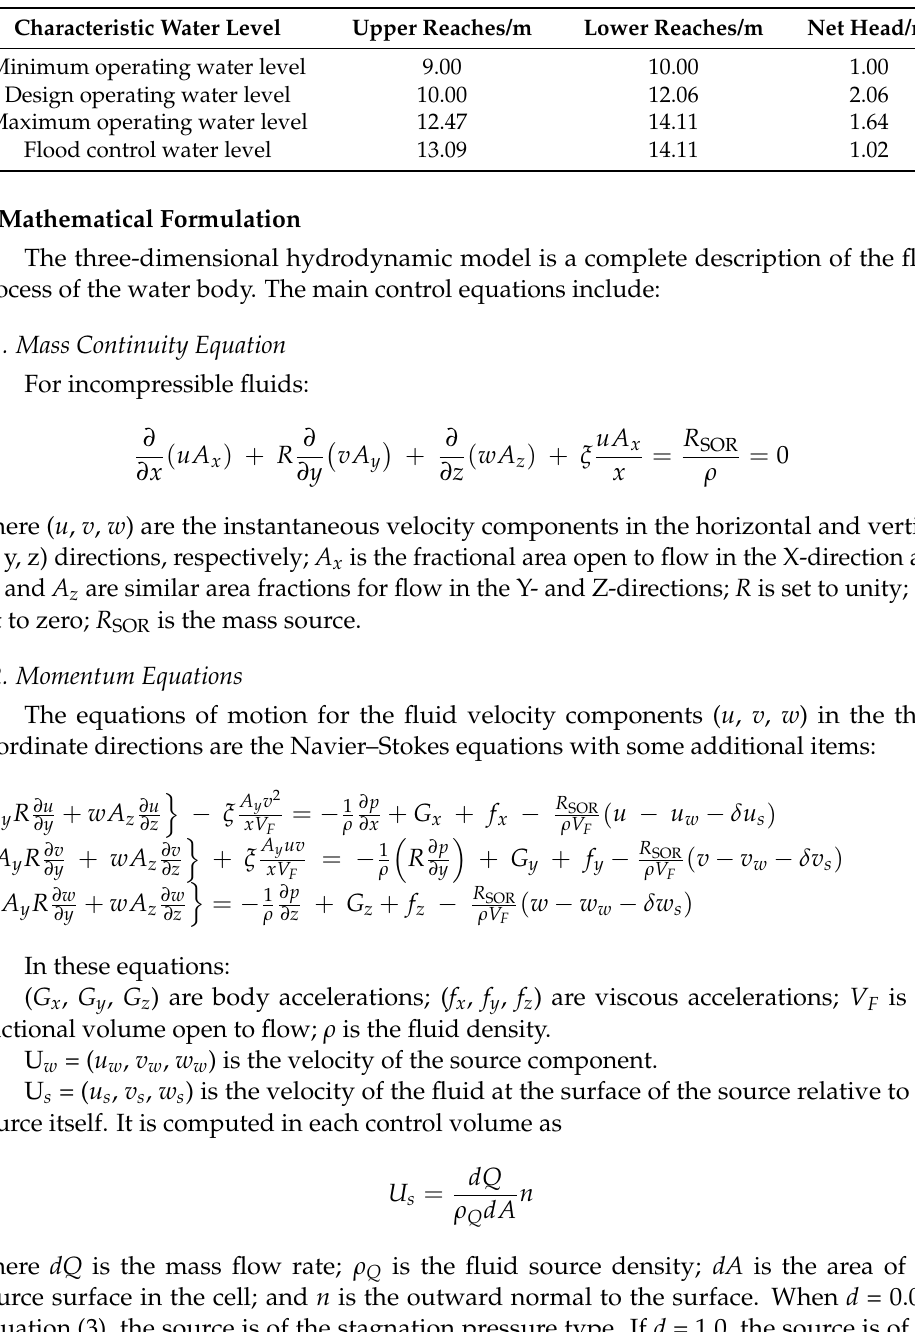
Table 1. Characteristic water level